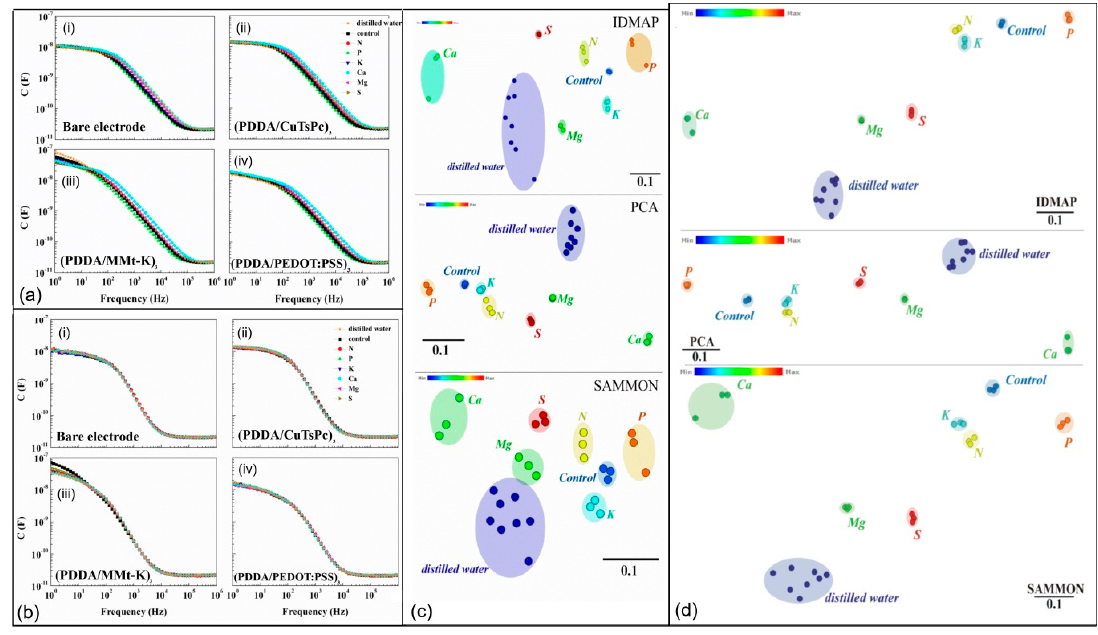
Figure 4. ( a ) Capacitance vs. frequency spectra of seven soil samples (N, P, K, Ca, Mg, S, and control) and ( b ) distilled water after each measurement using ( i ) bare electrode; ( ii ) (PDDA/CuTsPc) 3 ; ( iii ) (PDDA/MMt-K) 3 , and ( iv ) (PDDA/PEDOT:PSS) 3 ; ( c ) capacitance data using the whole frequency spectra; and ( d ) the selected frequency for the analysis of soil samples [34]. © 2017 by the